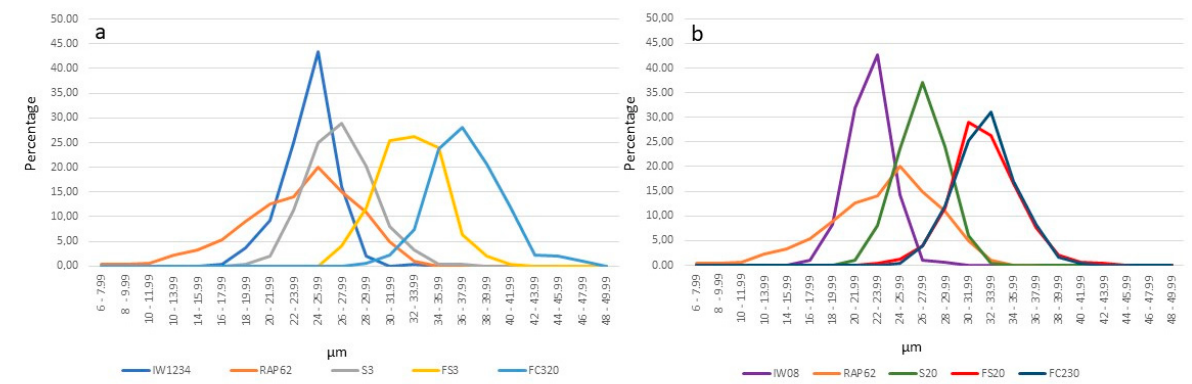
Figure 7. Distribution of stomata length in percentage in parental genotypes and interspecific hybrids. ( a ) Head cabbage IW1234, rapeseed RAP62, S3F1 (head cabbage IW1234 × rapeseed RAP62), FS3 F2 (S3 × self), and FS320 F2 (S3 × mixture of pollen). ( b ) Kale IW08, rapeseed RAP62, S20 F1 (IW08 kale × RAP62 rapeseed), FS20 (S20 × self), and FS230 F2 (S20 × mixture of